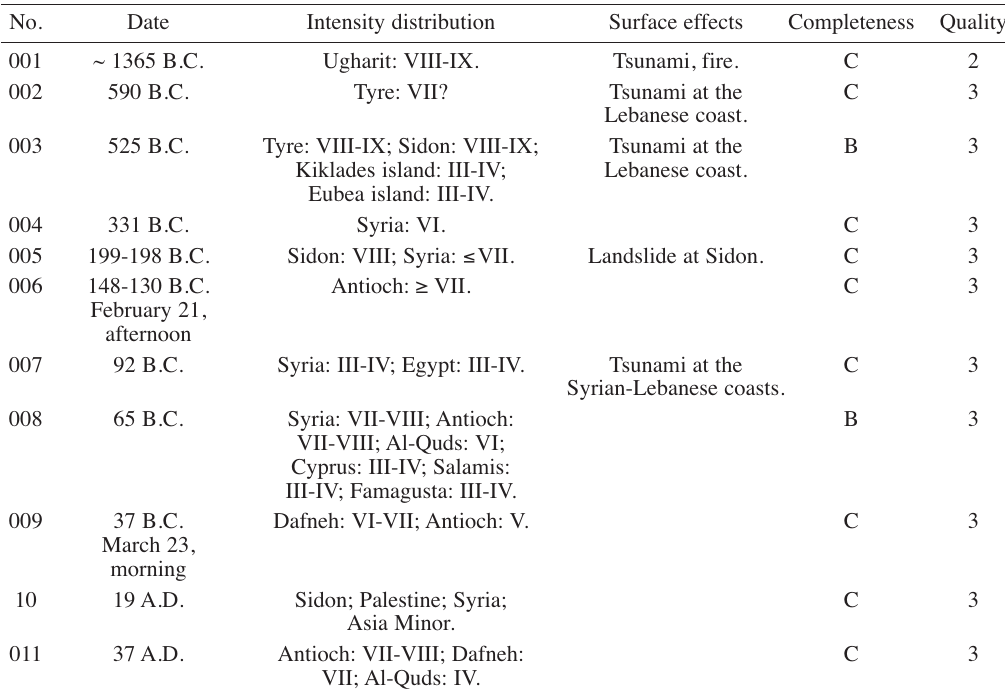
Table II. A complete table of historical earthquakes with estimated intensities at relevant localities and ac- companying effects, with information completeness (A – complete; B – accepted; C – incomplete) and infor- mation quality factors (1 – good source quality; 2 – moderate source quality; 3 – poor source quality)